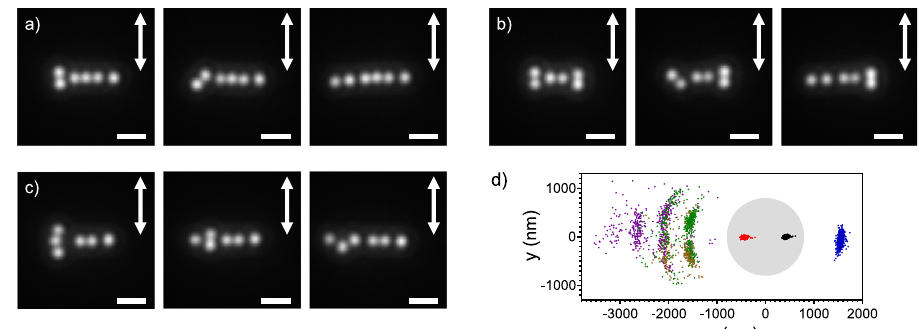
Fig. 5 | Scatteringimagesand spatial distributions fordifferentcon fi gurations ofsixtrappedAuNPs. ThenumberofNPsattheleftside,centerandrightsideare ( a )2:3:1,( b )2:2:2and( c )3:2:1,respectively.Thearrowsindicatethedirectionofthe